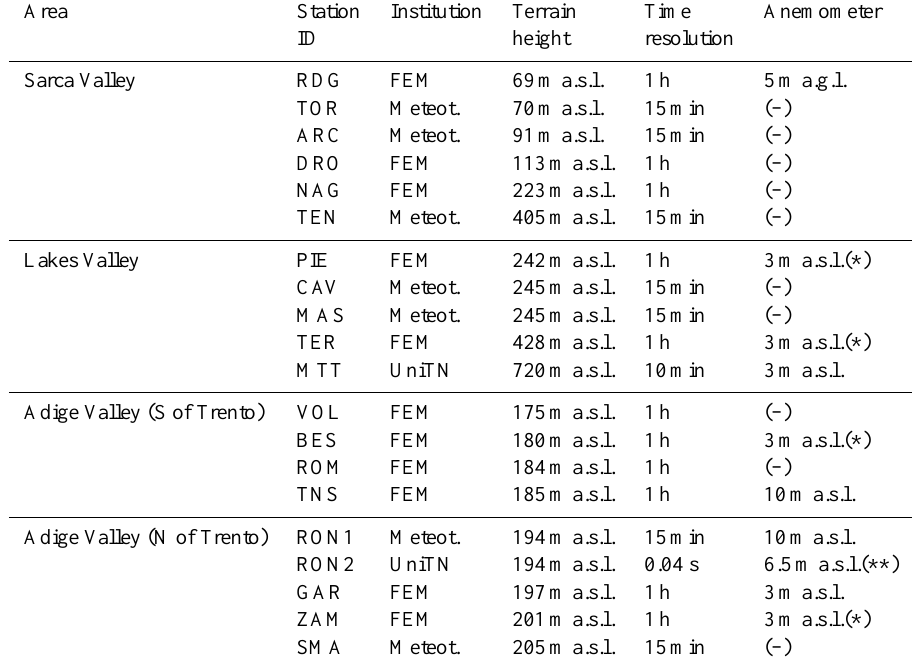
Table 2. List of surface AWSs, named as in Fig. 2 and grouped by geographic area. Operating institution: FEM indicates the Edmund Mach Foundation, Meteot. stands for Meteotrentino (i.e. the Meteorological Office of the Autonomous Province of Trento) and UniTN is the University of Trento. Local terrain height and height of the anemometer (where present) are also reported. (*) indicates anemometers recording only wind speed. (**) indicates the ultrasonic anemometer operated by UniTN. (–) indicates that no anemometer is installed at the